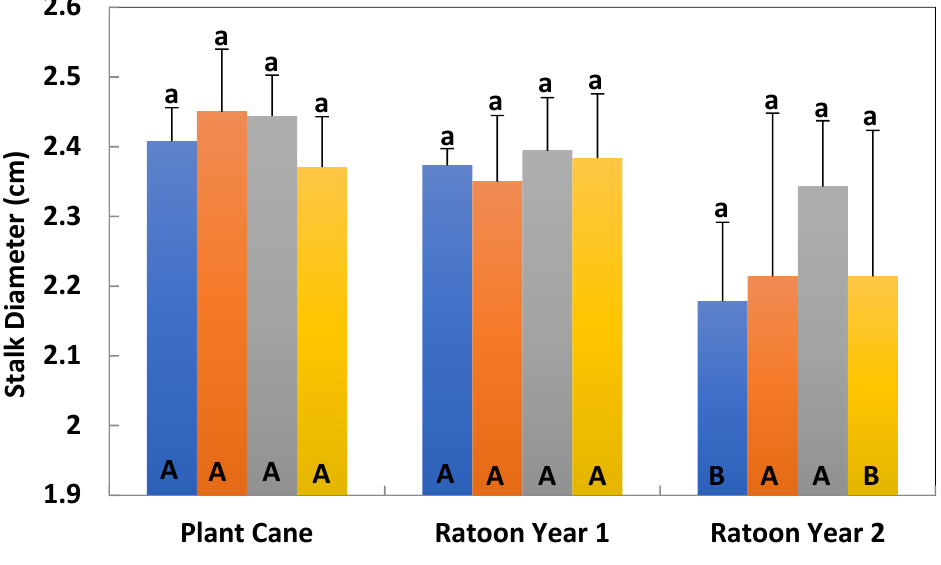
Figure 1. Stalk diameter for plant cane and two ratoons (mean and standard deviation). Different lower case letters within the same crop year are significantly different ( p < 0.05). The same treatment with different upper case letters for plant cane and two ratoons are significantly different ( p < 0.05).